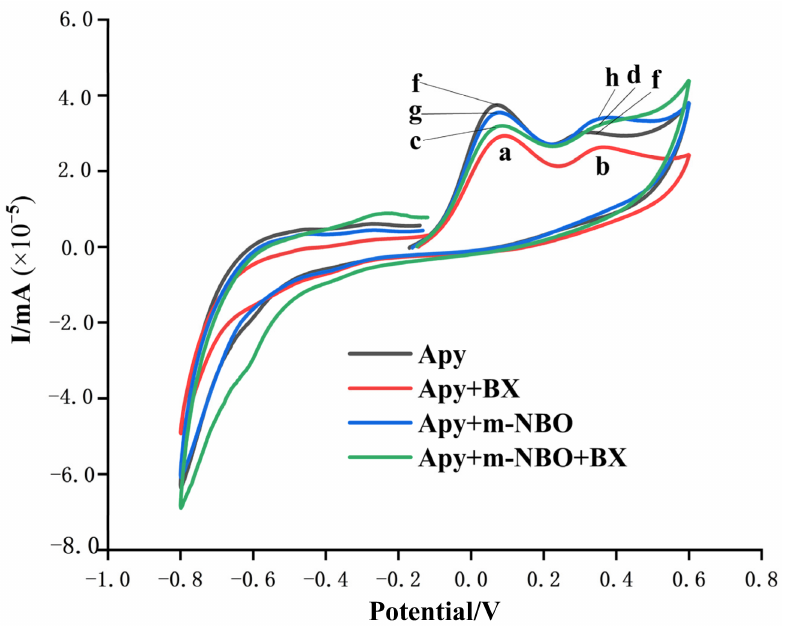
Figure 9. CV curves of the arsenopyrite electrode in the presence of m-NBO and NaBX at pH = 11.5; scanning rate: 10 mV/s, C(m-NBO) = 0.3 mol · L − 1 , C(NaBX) = 1.6 × 10 − 3 mol · L − 1